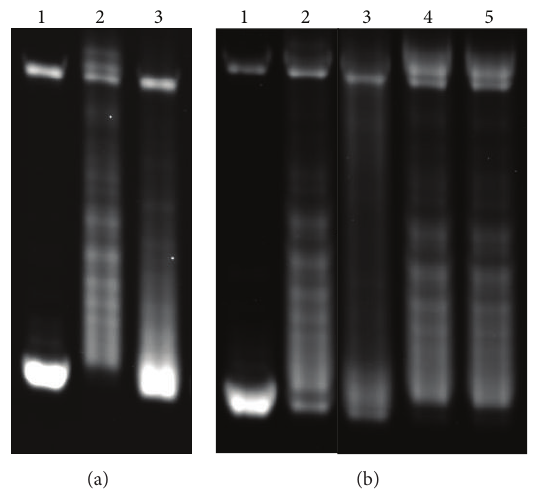
Figure 1: R-loop formation on pSK-(AGGAG) 22 and effects of RNase T1 on the formation. A plasmid containing a (AGGAG) 22 repeat was transcribed with T7 RNA polymerase and the effects on the topology of the plasmid were examined by agarose gel elec- trophoresis. (a) Lane 1: mock transcribed; lane 2: transcribed with T7 RNA polymerase; lane 3: transcribed with T3 RNA polymerase. (b) Lane 1: mock transcribed, lane 2: transcribed with T7 RNA polymerase, lane 3: transcribed with T7 RNA polymerase in the presence of 3 units of RNase T1; lane 4: transcribed with T7 RNA polymerase and ethanol-precipitated; and lane 5: transcribed with T7 RNA polymerase, ethanol-precipitated, and then incubated with 3 units of RNase